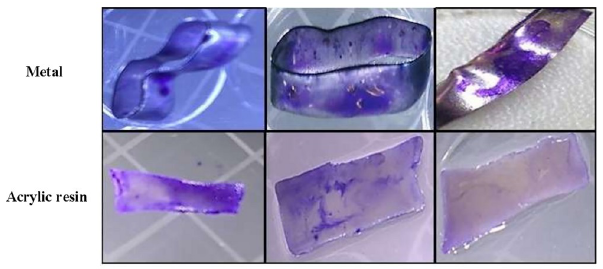
Fig 2. Candida biofilm formation on abiotic surfaces (4A: Metal and 4B: Acrylic resin) after 48